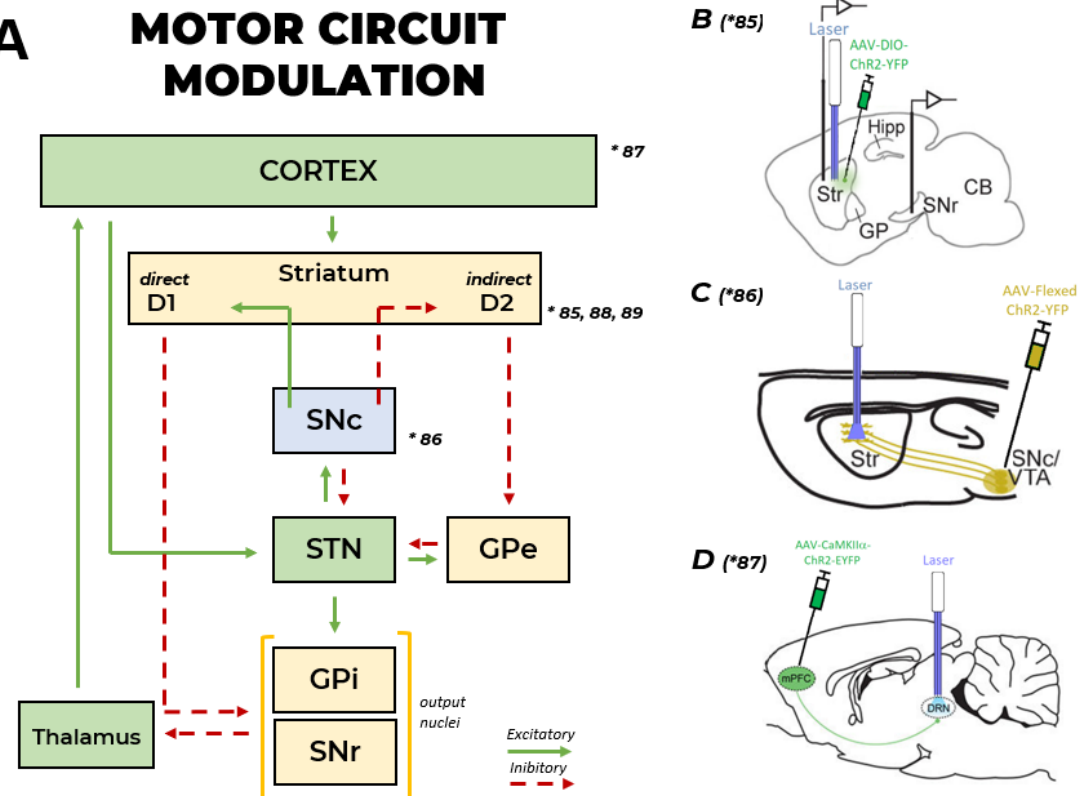
Figure 2. Optogenetic application to study the cortical-basal ganglia-thalamocortical circuit involved in motor control. ( A ) Connectivity diagram showing excitatory and inhibitory pathways. Abbreviations: D1 and D2, dopamine receptor subtypes. SNc, substantia nigra pars compacta. STN, subthalamic nucleus. GPe, external glob pallidus. GPi, internal globus pallidus. SNr, substantia nigra pars